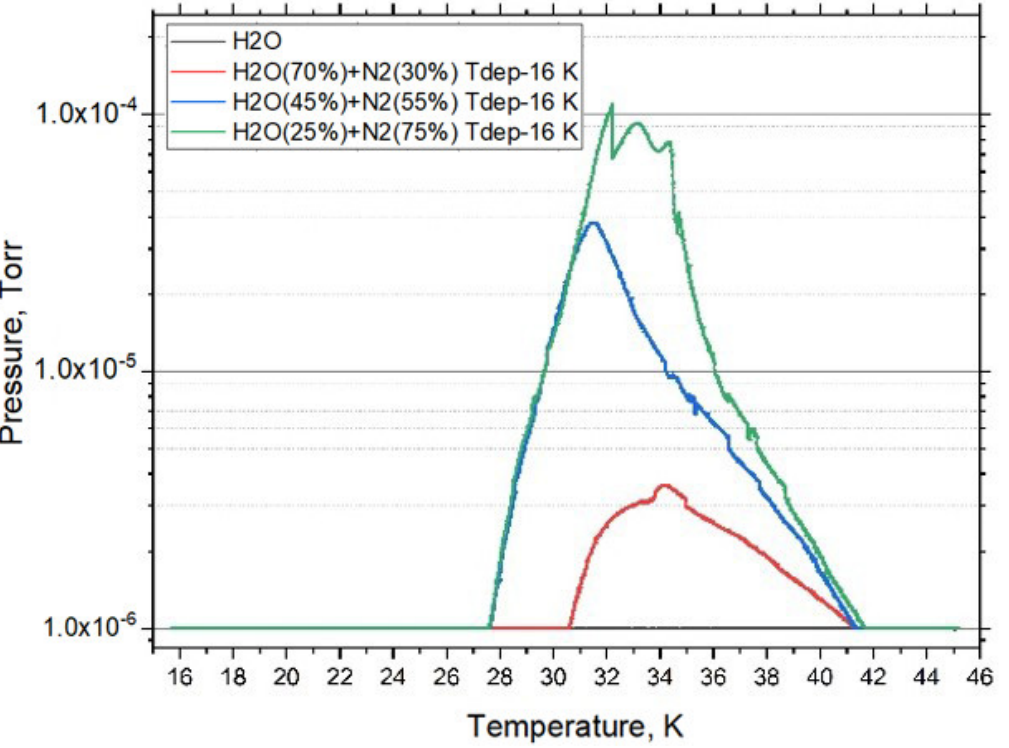
Figure 10. Changes in the pressure in the chamber when nitrogen of various concentrations escapes from the film.